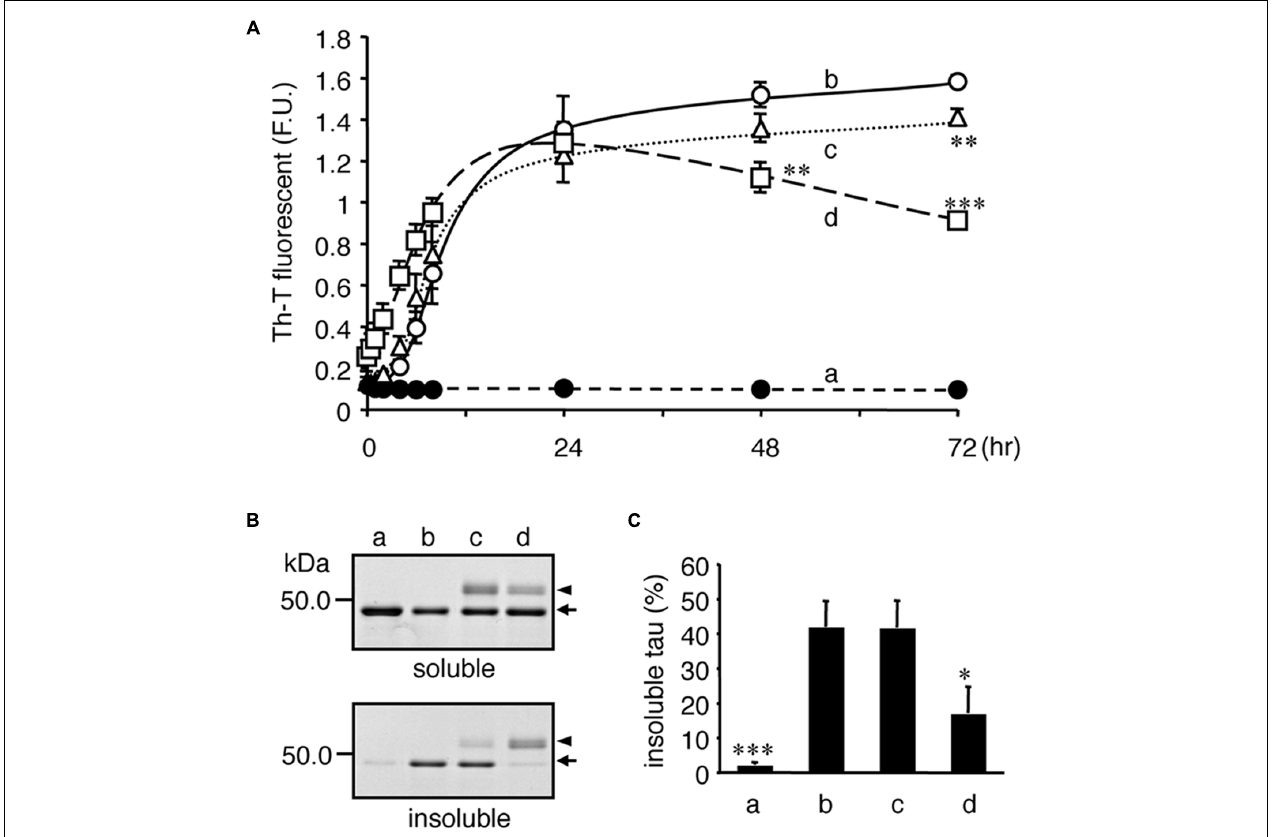
FIGURE 9 | Tubulin inhibits heparin-induced aggregation of tau. Recombinant tau (a–d) and tubulin (0.2 mg/ml; c , 1.0 mg/ml; d ) were incubated without (closed: a ) or with (open: b–d ) heparin at indicated periods. (A) Time courses of Th-T fluorescence change are shown (means ± SEM, n = 4). The statistical significance compared to controls (+heparin, 0 mg/mL tubulin) was analyzed by Tukey’s post hoc test ( ∗ p < 0.05 , ∗∗ p < 0.01 , and ∗∗∗ p < 0.001 ). (B) After 72 hincubation, the proteins were subjected to the Sarkosyl-solubility assay as described in the Materials and Methods section. Gel images of CBB staining of total, Sarkosyl-soluble, and Sarkosyl-insoluble fractions are shown. Arrows and arrowheads indicate tau and tubulin, respectively. Note that the Sarkosyl-insoluble tau was reduced in the presence of tubulin (the arrow in lowest panel). (C) The amounts of Sarkosyl-insoluble tau were quantified (means ± SEM, n = 4). Statistical significance was analyzed by Tukey’s post hoc test ( ∗ p < 0.05, ∗∗∗ p < 0.001